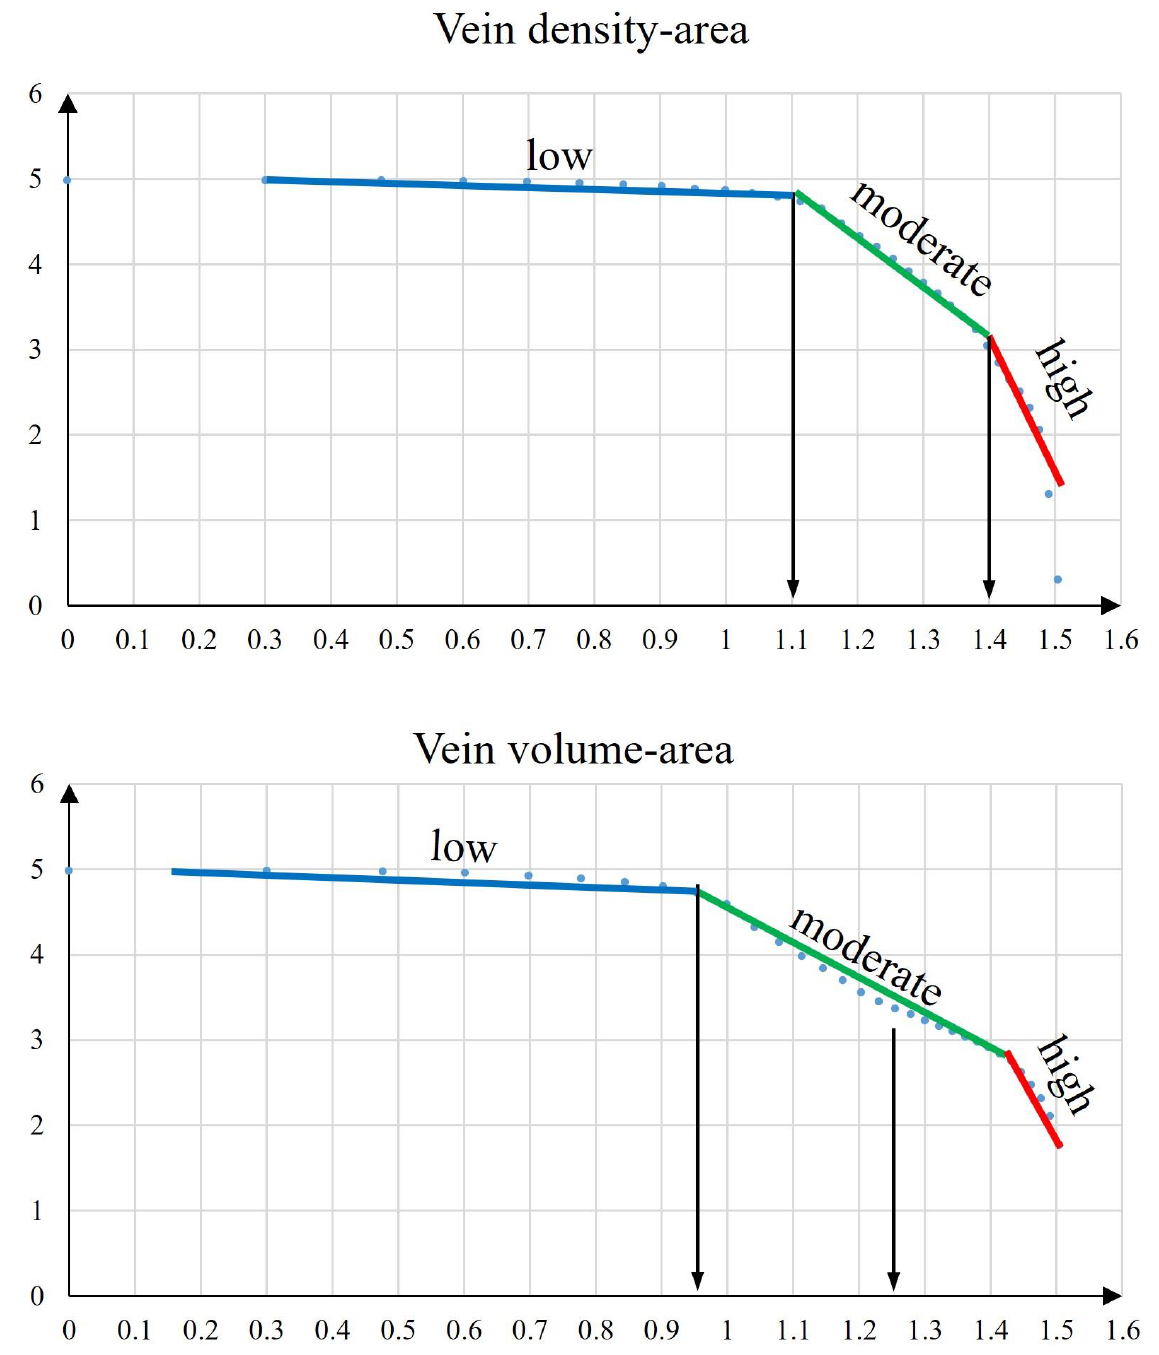
Figure 11. Log – log plots (C – A method) for vein density and vein volume. Figure 11. Log–log plots (C–A method) for vein density and vein